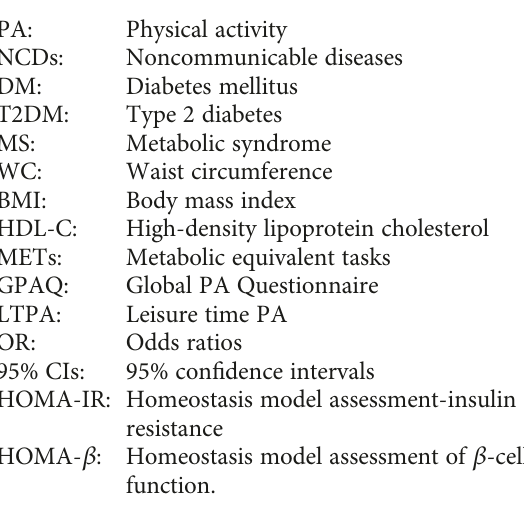
Table 1: univariate logistic regression between social behav- iors and physical activity (high level versus the other